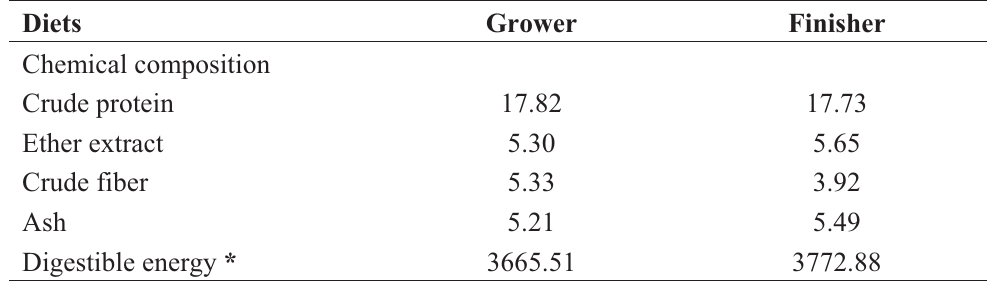
Table 1. Chemical composition (g/100 g DM) and Ingredients of